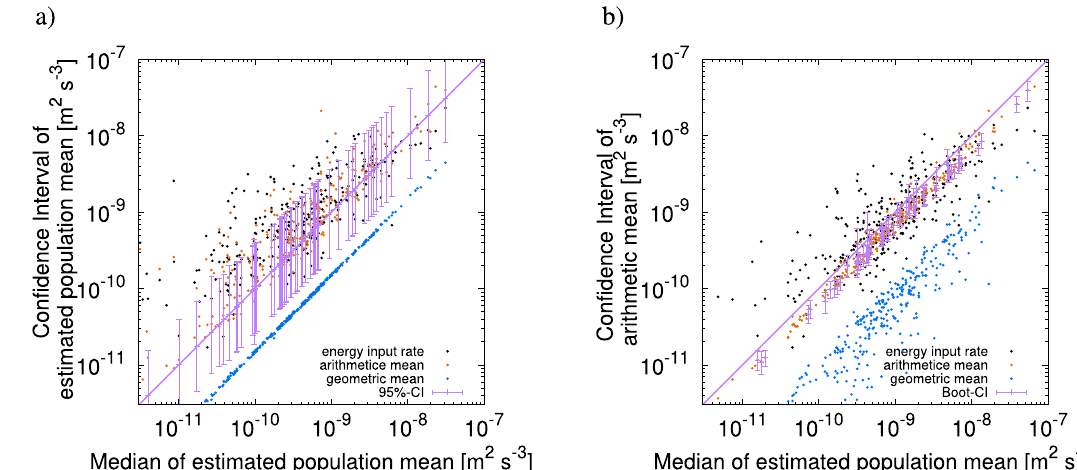
Figure 11. Result of control experiments. Median (horizontal axis) versus confidence interval (vertical axis) of ǫ , which are obtained using ( a ) joint probability density function based on the cascade model with Gaussian generators, and ( b ) the bootstrap method. For given values of the median on the horizontal axis, the points on the vertical axis indicate the values of the confidence interval (purple segment), arithmetic mean (orange), geometric mean (blue), and energy input rate (black). For readability, 300 points and 60 intervals are drawn out of 30,000